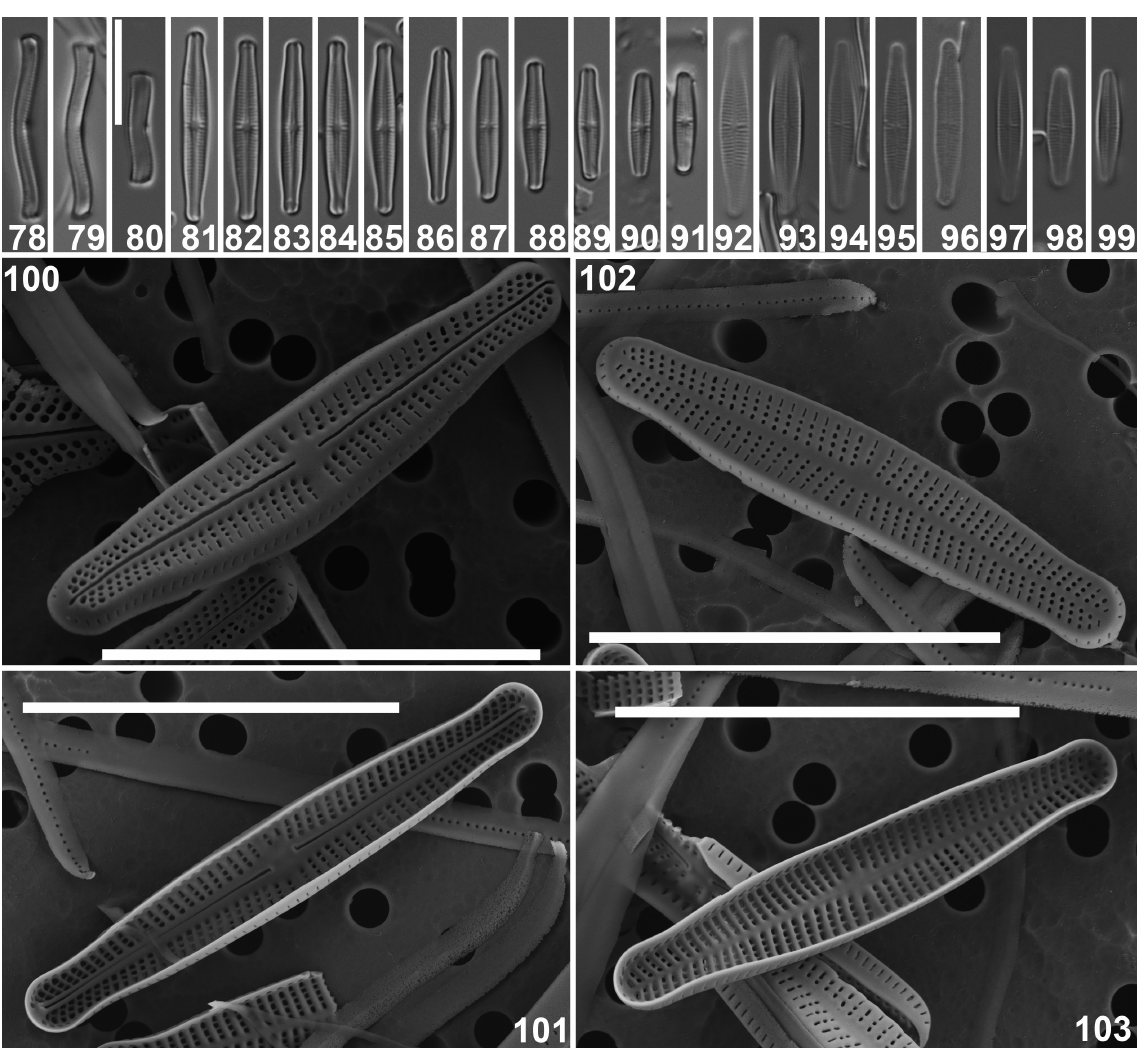
Figs 78-103. Achnanthidium sieminskae Witkowski, Kulikovskiy & Riaux-Gobin. Light and scanning electron micrographs of a population on Iles Kerguelen. 78-80 . LM views of some frustules in girdle view. 81-91 . LM views of raphe valves. 92-99 . LM views of rapheless valves. 100 . SEM external view of an entire raphe valve. 101 . SEM internal view of an entire raphe valve. 102 . SEM external view of an entire rapheless valve. 103 . SEM internal view of an entire rapheless valve. Scale bars represent 10